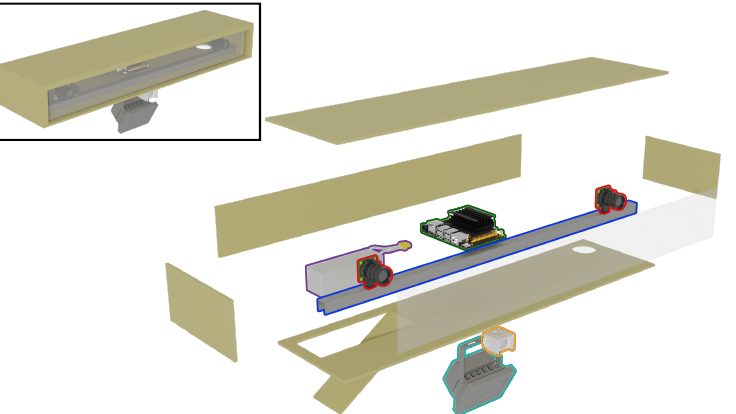
Figure 4. The 3D visualization of SOCRATES. The important components will be covered in the following text and are highlighted here, i.e., cameras (red outline), baseline rail (blue outline), control unit (green outline), battery (violet outline), infrared illumination (turquoise outline), passive IR sensor (Orange outline) Details such as the power supply, wiring, and screws are omitted. The following 3D parts of the model were obtained from external sources: Raspberry Pi HQ cameras